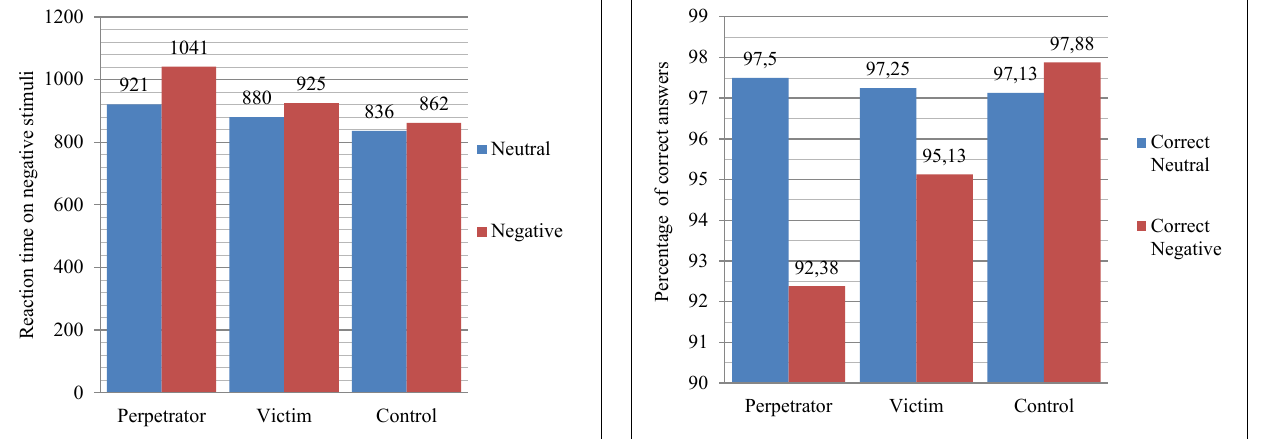
FIGURE 1 | Differences in the interference effect between the groups of perpetrators, victims, and the control group to neutral and negative stimuli in the series proper (for details see Table 1 ).